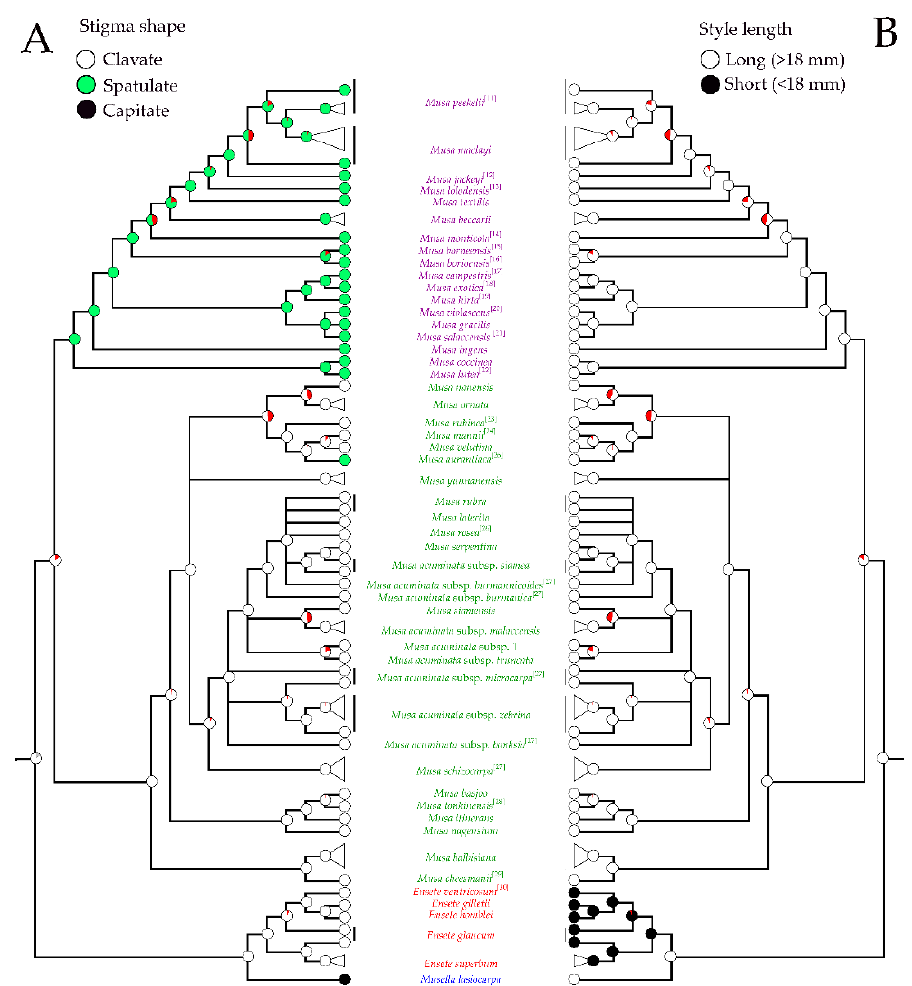
Figure 5. Phylogenetic trees of Musaceae based on the stigma shapes ( A ) and the style lengths ( B ) of male flowers. The trees show ancestral state reconstruction based on Bayesian posterior probabilities of selected morphological states on Bayesian topology constructed from nrDNA and plastid combined data. The tree separated banana clades including Musella (blue font), Ensete (red font), species of the sect. Musa (green font) and species of the sect. Callimusa (purple font). Circles on nodes show character changes between the taxa, red pies represent node absent and gray pie represent equivocal. Morphological characters from other publications were labeled with reference number